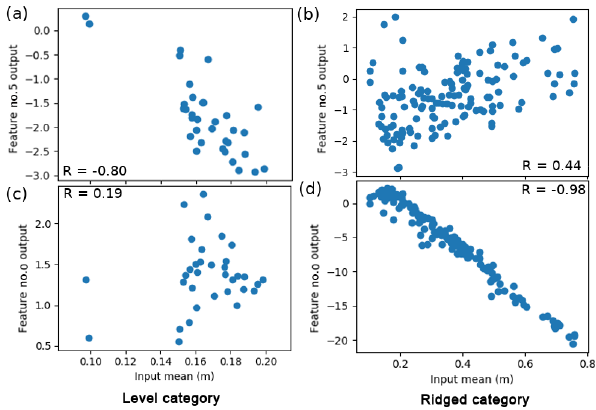
Figure 13. Scatter plot showing correlations between features and real-life metrics. Here, features 0 and 5 correlate strongly to the mean elevations of the level and ridged surfaces, respectively, but not the other way around. This suggests that the level and ridged surfaces are treated differently, implying a different effective den- sity of the surface freeboard. The correlation for the level category is not as strong; without the two points near x = 0 . 1, | R | = 0 . 64, so this feature is possibly a combination of the mean elevation and something